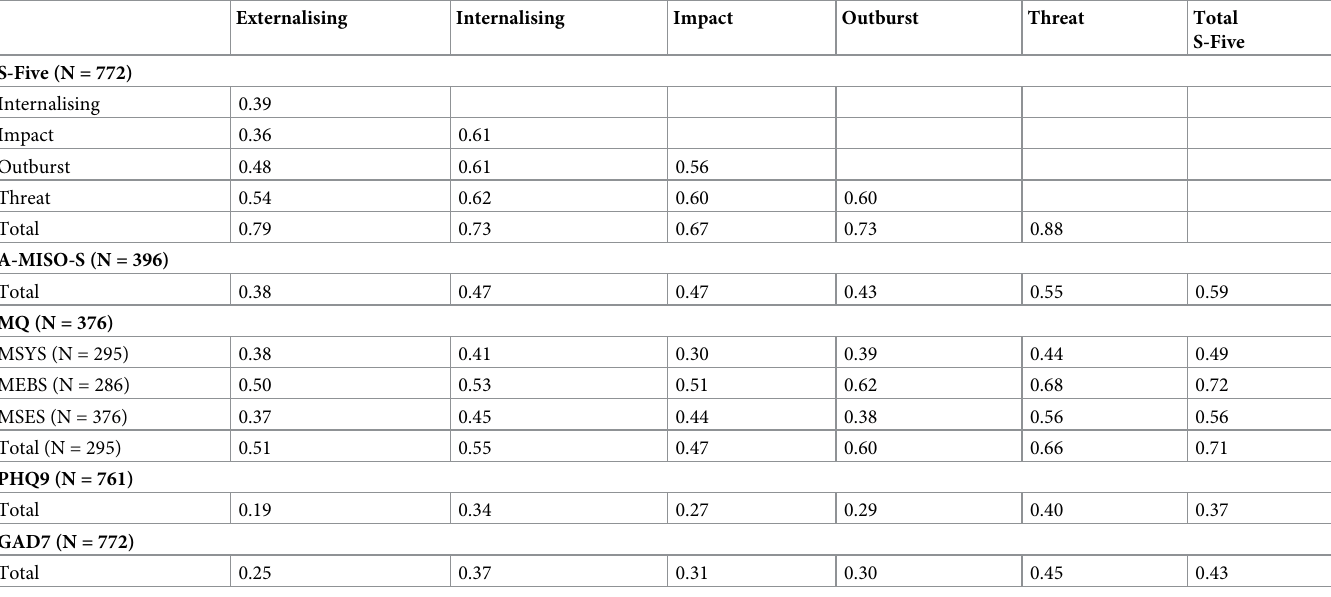
Table 3. Intercorrelations of the S-Five scores, and correlations with other measures